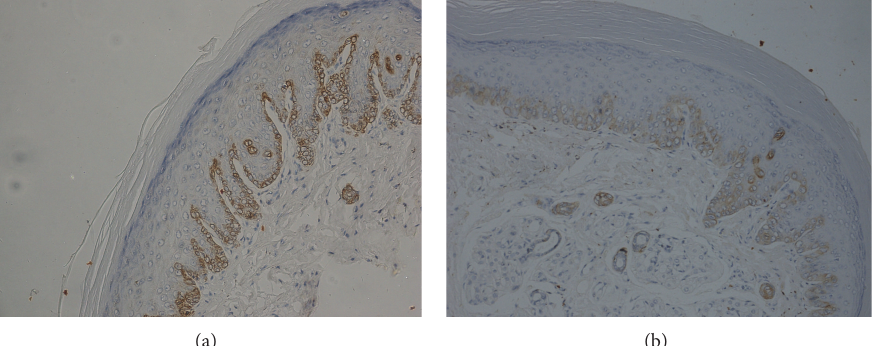
Figure 4: Immunohistochemical analysis of VEGF-A in the epidermis of mice fed a normal (a) or a high-fat diet (b). Original magnification ×